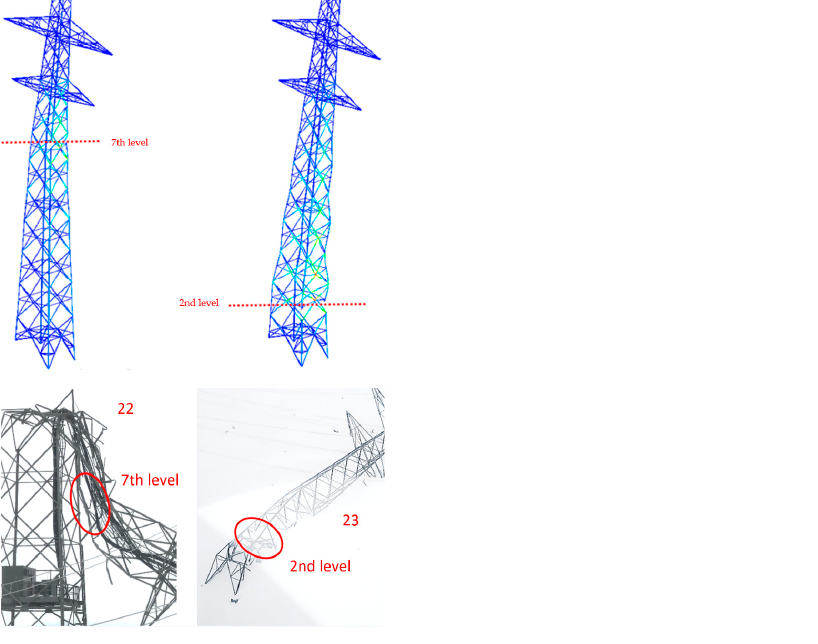
Figure 27. Post-buckling deformation compared against the real failure, at the 2nd level (on the right side) and 7th level (on the left side). Note that tower No. 23 (modeled) had the same upper structure (above the 5th section, reference Figure 19 for section numbering) as all the other towers in the line segment (including the No. 22 showed in the picture on the left); thus, it can be assumed that wind loads and failure modes in the upper part were the same in every